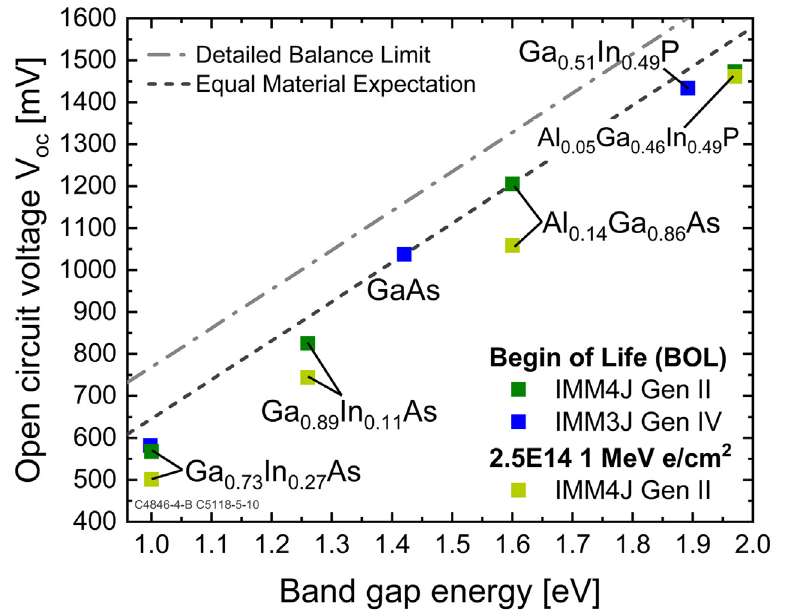
Fig. 6. From spectral electroluminescence measurements, IV data and measured quantum ef fi ciencies calculated subcell open circuit voltages for the IMM4J before and after 2.5 (cid:1) 10 14 1MeV e – /cm 2 electron irradiation. The calculated subcell open circuit voltages for the latest generation of IMM3J are shown as comparison. The parallel curve (shifted downwards by 123 mV) to the radiative limit [23] serves as guide to the eye and can be interpreted as guide for equal material